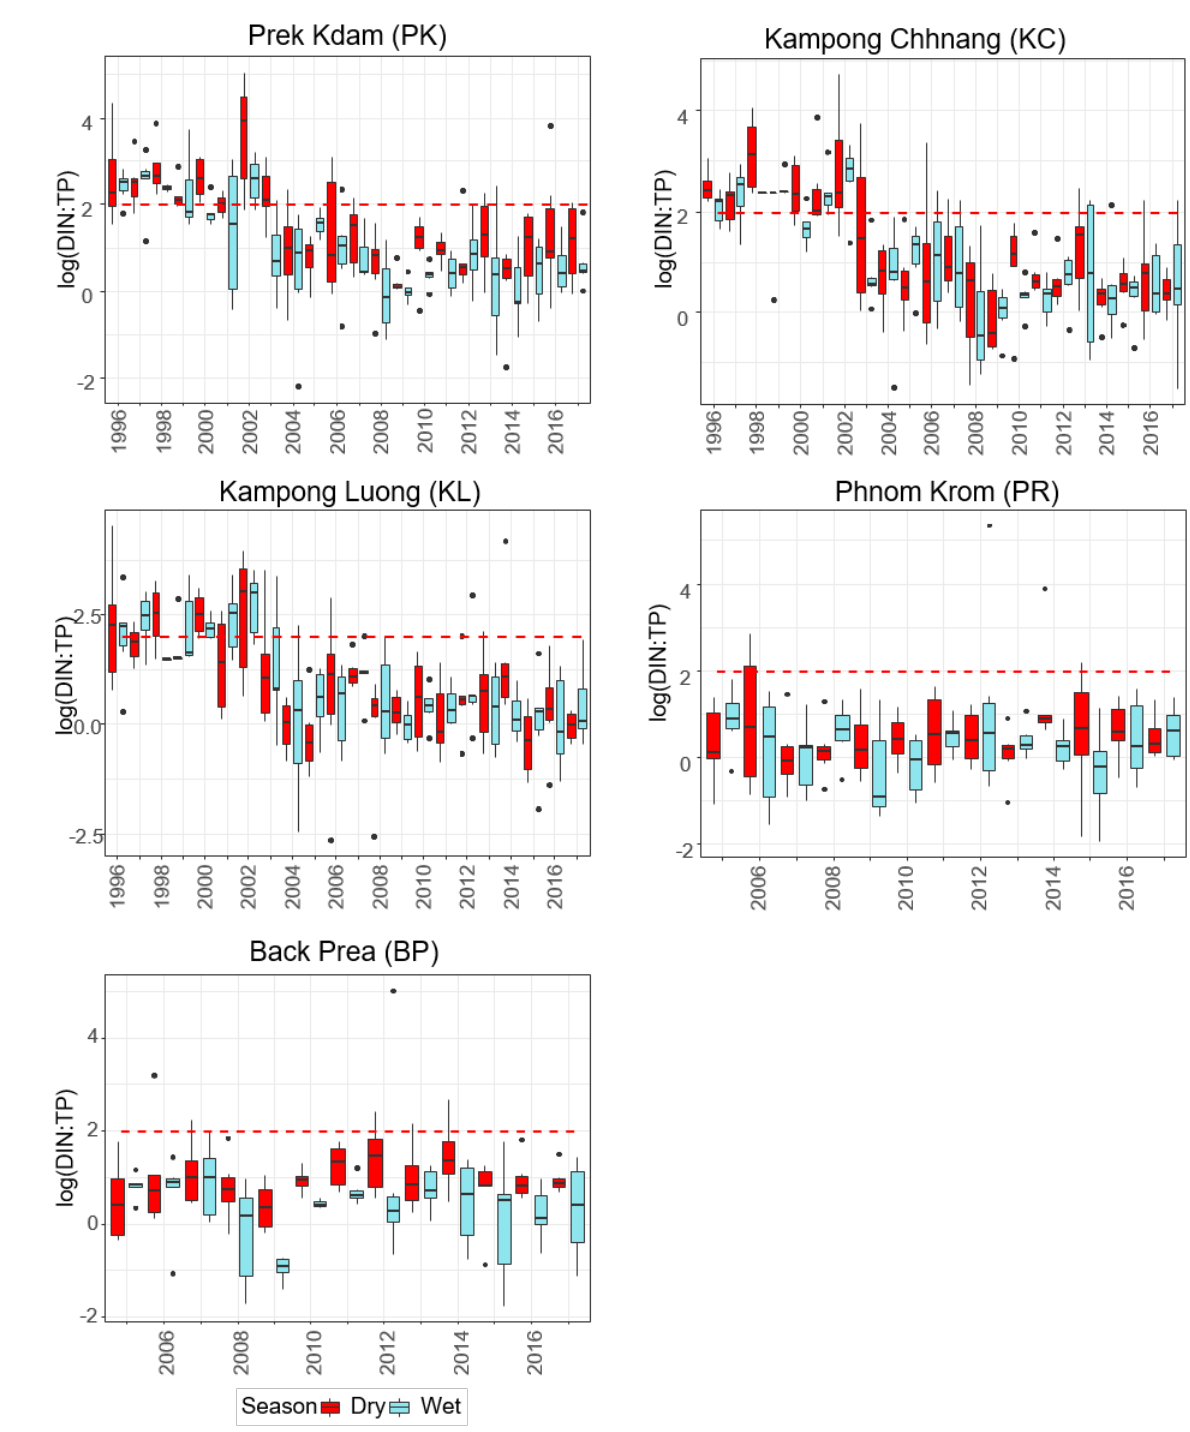
Figure 3. Temporal variation of the DIN:TP by weighted mass ratio, and grouped by wet and dry seasons. The red dashed line indicates the ratio equal to 7.2 which is the potentially optimized, nitrogen to phosphorus ratio as determined by Redfield during study periods needed for phytoplankton growth.